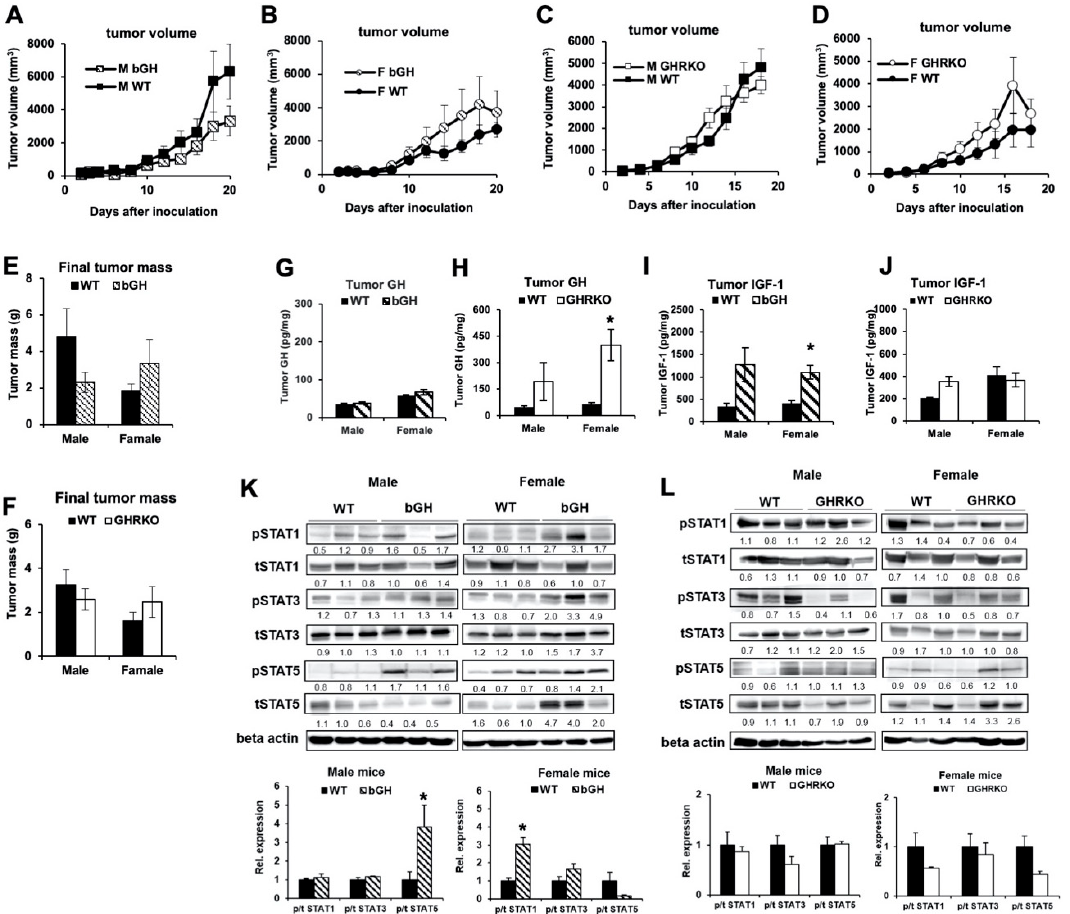
Figure 2. Subcutaneous B16-F10 mouse melanoma growth in bGH and GHRKO syngeneic mice. ( A ) Subcutaneous B16-F10 tumor growth in male bGH (n = 5) vs. WT mice (n = 6). ( B ) Subcutaneous B16-F10 tumor growth in female bGH (n = 7) and WT mice (n = 6). ( C ) Subcutaneous B16-F10 tumor growth in male GHRKO (n = 6) vs. WT (n = 8) mice. ( D ) Subcutaneous B16-F10 tumor growth in female GHRKO (n = 4) and WT mice (n = 5). Tumor sizes were analyzed by repeated measures (SPSS). ( E ) Weight of subcutaneous B16-F10 tumors from bGH vs. WT mice at dissection. ( F ) Weight of subcutaneous B16-F10 tumors from GHRKO vs. WT mice at dissection. ( G ) GH levels were measured in protein lysates isolated from tumors of bGH and WT mice using ELISA and normalized to total protein concentrations (n = 4). ( H ) Similar GH measurements were performed in protein lysates isolated from tumors of GHRKO and WT mice (males n = 3, females n = 4). ( I ) IGF-1 levels were measured in protein lysates isolated from tumors of bGH and WT mice using ELISA and normalized to total protein concentrations (n = 4). ( J ) Similar IGF-1 measurements were performed in protein lysates isolated from tumors of GHRKO and WT mice (males n = 3, females n = 4). ( K ) Representative images of western blot analysis of phosphorylation (p) and total (t) levels of STAT1, STAT3 and STAT5 in protein lysates isolated from tumors of bGH and WT mice. Densitometry analysis was performed and normalized against β -Actin. The relative expression levels (fold change relative to WT) are labeled under each band. The ratio of phosphorylated vs. total protein levels in tumors from bGH and WT mice are presented in bar graphs (n = 4). ( L ) Representative images of western blot analysis of phosphorylation and total levels of STAT1, STAT3, and STAT5 in protein lysates isolated from tumors of GHRKO and WT mice. (males n = 3, females n = 4). Data are presented as mean ± standard errors (*, p < 0.05, unpaired student’s t -test).